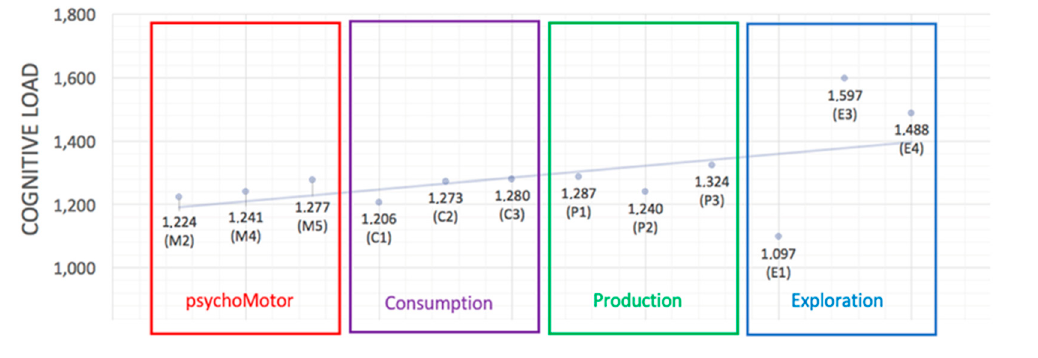
Figure 2. Graphical representation of averaged cognitive load for the 12 evaluated